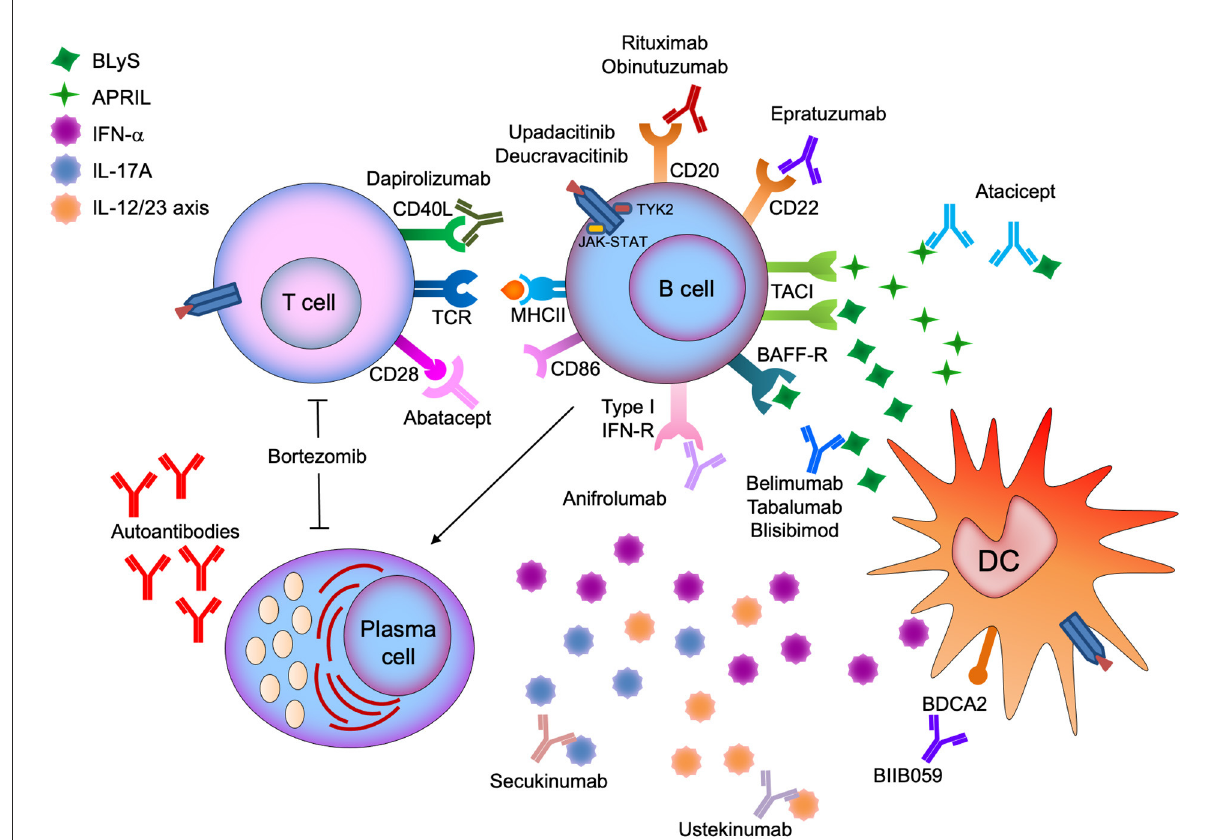
FIGURE1 Illustration of the main mode of action of compounds studied for the treatment of systemic lupus erythematosus (SLE) and lupus nephritis (LN) that exert direct or indirect effects on B